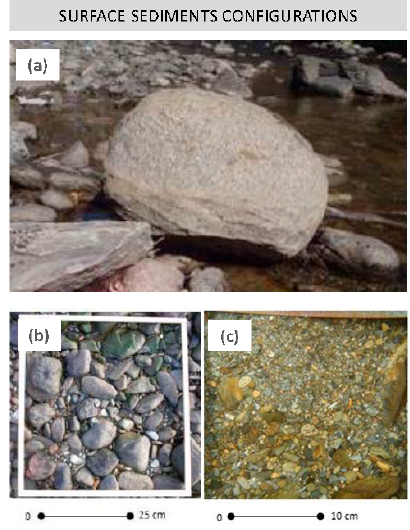
Figure 3. Surface sediments configurations: ( a ) Structural bed-material, ( b ) Coarse surface layer formed by movable cobbles and gravels and ( c ) Patches of fine sediments (fine gravels and sand).